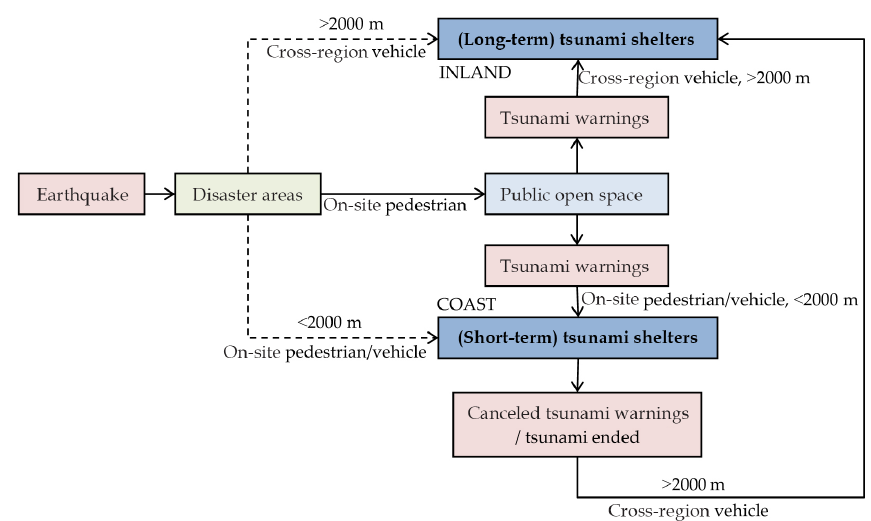
Figure 3. Tsunami evacuation time–space routes with major evacuation activities. Table 2. List of accessibility indicators for this study. Spatial scale Traffic tool Roadway Indicator Type Measure Cross-region Vehicle Regional expressway evacuation